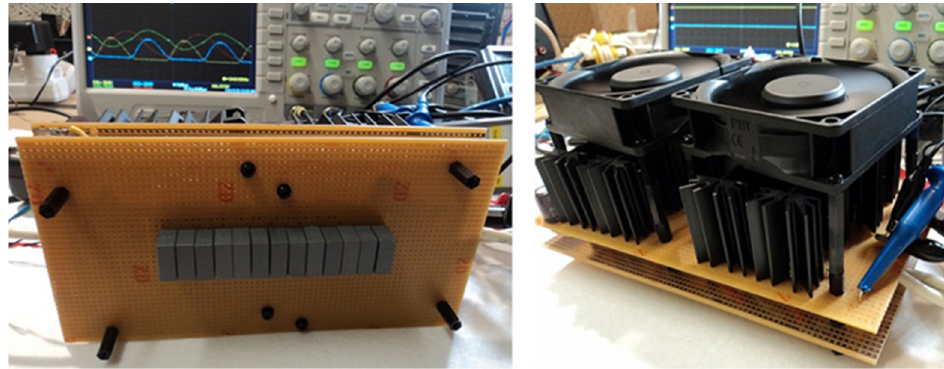
Figure 10. Improving the converter construction, given in Figure 6.